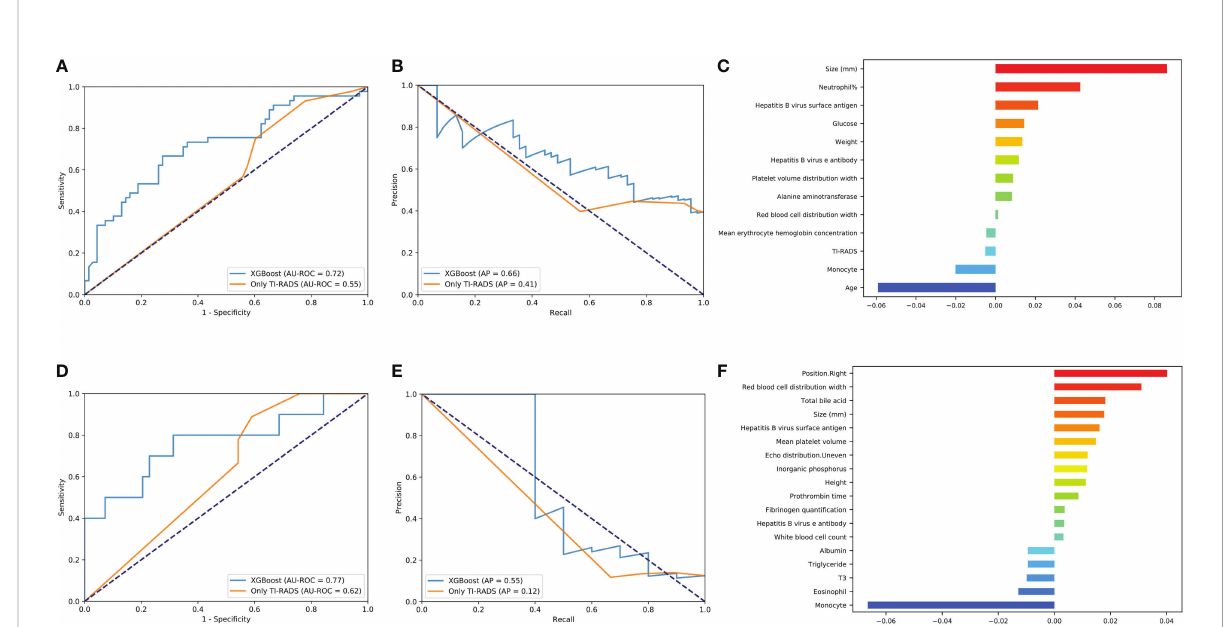
FIGURE 3 Evaluation of the central area and cervical metastasis predictive models. (A, D) The average ROC curves from of XGBoost and Only TI-RADS models in the validation sets. (B, E) The average PR curves, indicating the tradeoff between precision and recall. (C, F) The histogram describes the important features of the XGBoost predictive model for central area and cervical